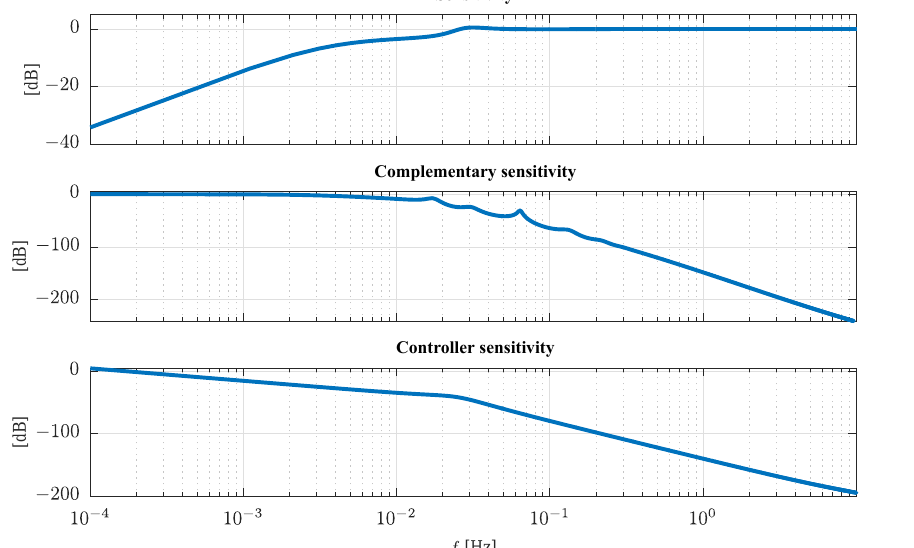
Figure 13. Sensitivity S , complementary sensitivity T , and controller sensitivity U analysis of the closed-loop